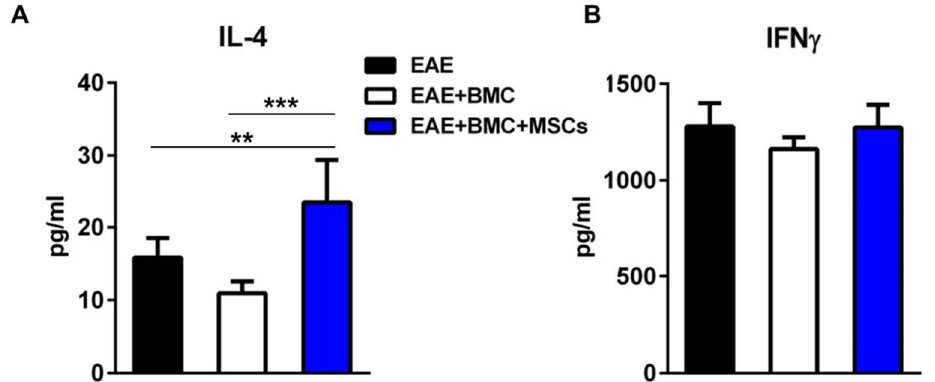
Figure 4. Anti-inflammatory IL-4 is upregulated in co-transplanted mice. Quantification of ( A ) IL-4 and ( B ) IFN-γ in plasma from EAE-affected mice untreated, irradiated and treated with HSCs, or irradiated and co-transplanted with HSCs and MSCs, at 12 days post-treatment. Data are presented as mean ± SEM cytokine concentration of triplicate plasma samples of n = 4 mice per group. ** p < 0.01 *** p < 0.001.